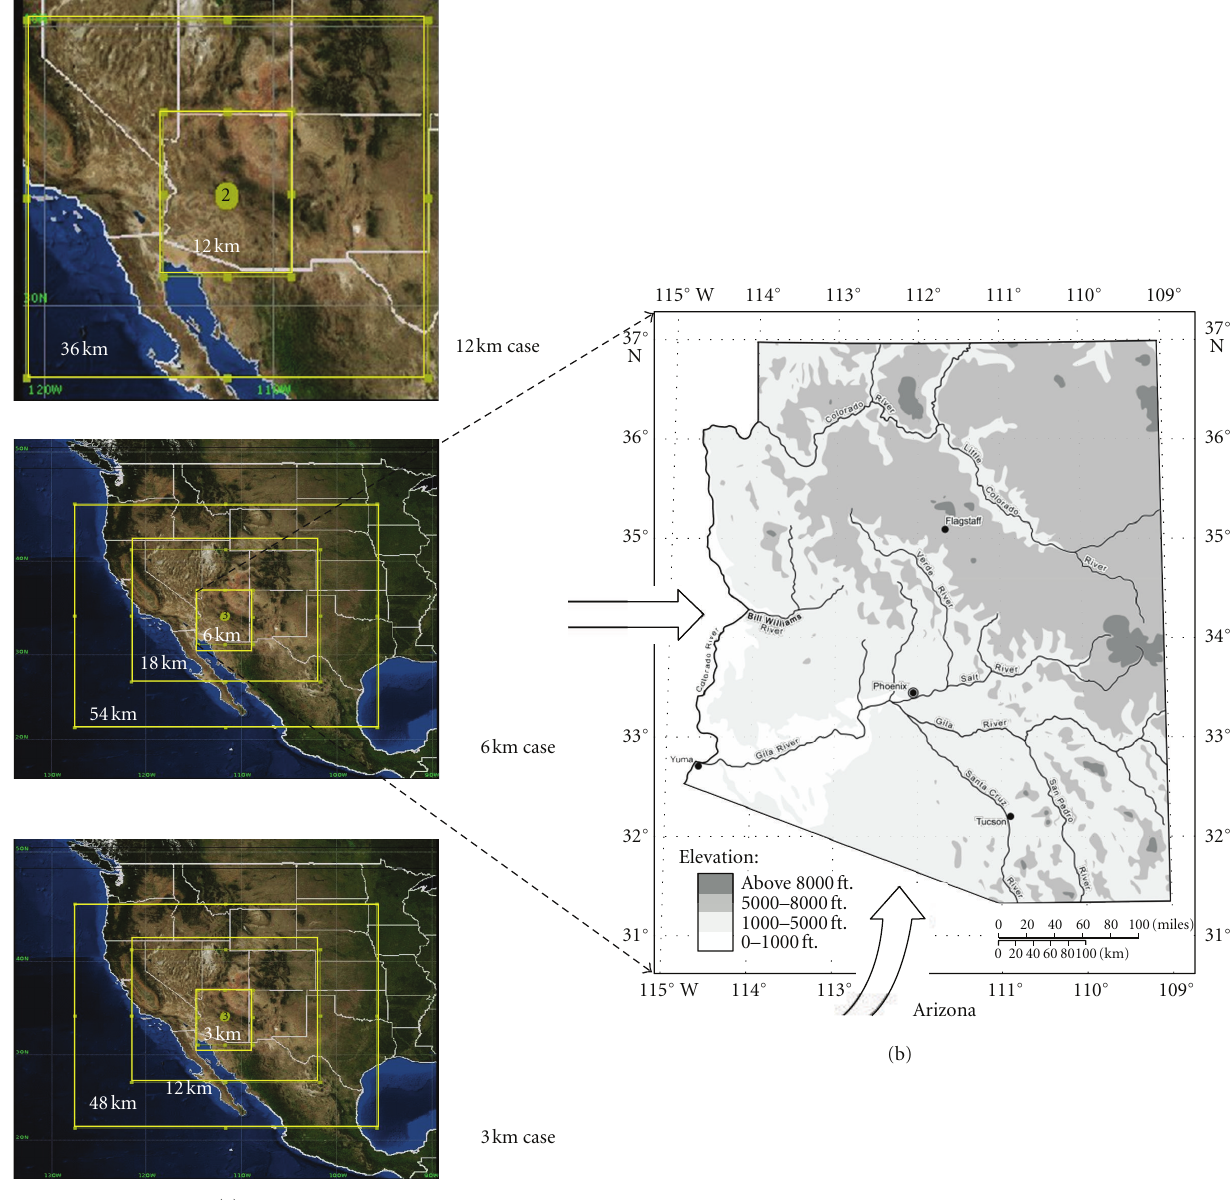
Figure 1: The model domains and arrangement of nesting for the numerical experiments: (a) nested domains for WRF model and (b) an illustration that the innermost domain covers the State of Arizona. The arrows indicate the prevailing directions of moisture fluxes into Arizona in wintertime [18]. The topographic map is taken from Arizona Geographic Alliance, Arizona State University (http://geoalliance.asu.edu/azga/).